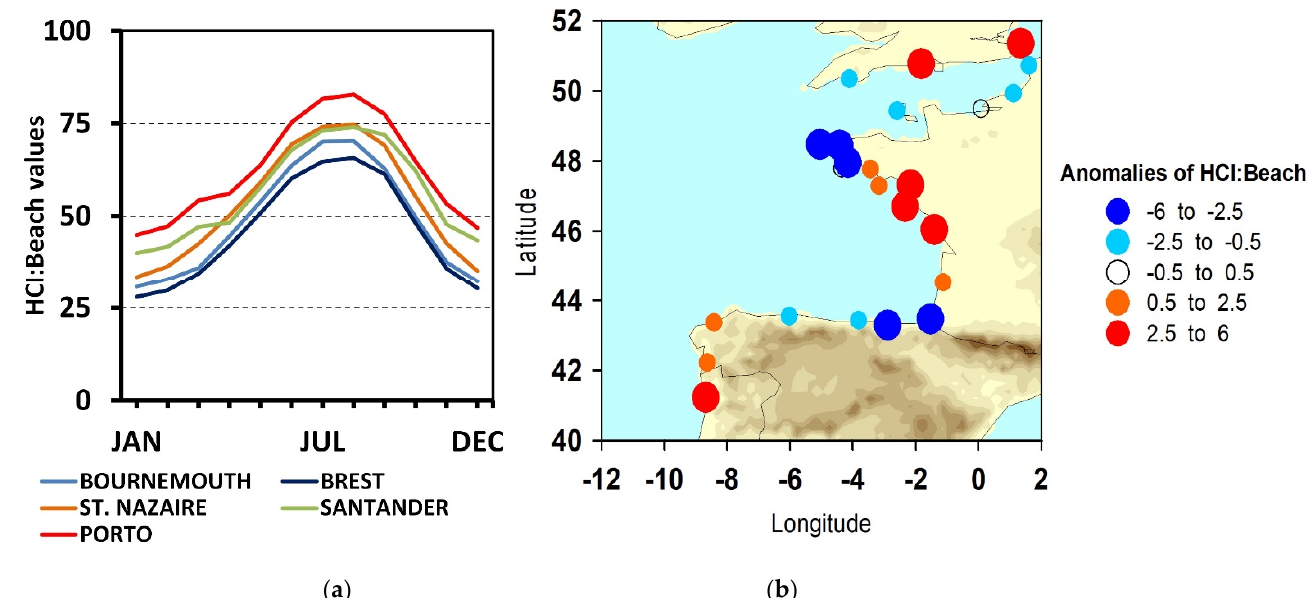
Figure 2. ( a ) Monthly averages of the HCI: Beach index in selected locations of the study area; ( b ) Spatial anomalies of the summer (July–August) HCI: Beach after regression against latitude.